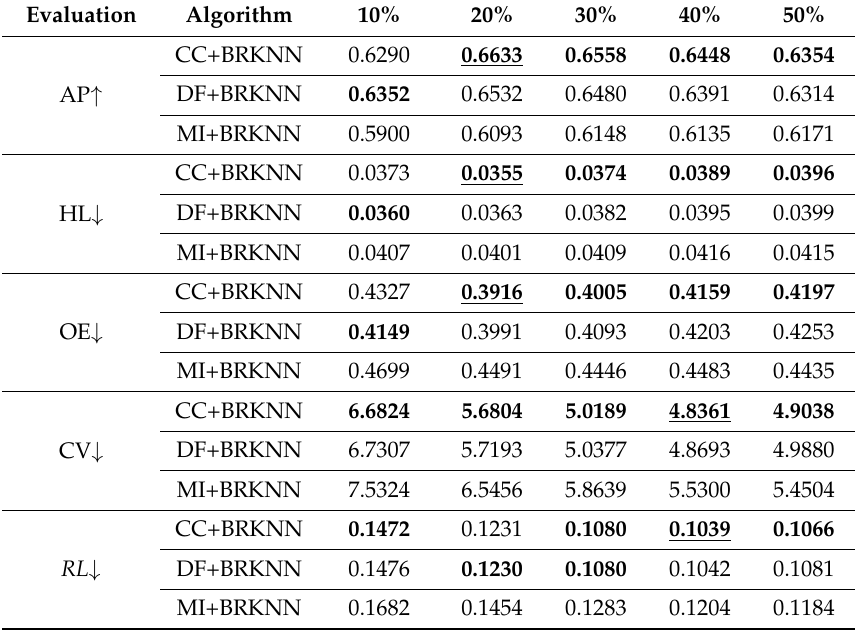
Table 11. Comparison of classification performance on Computers data